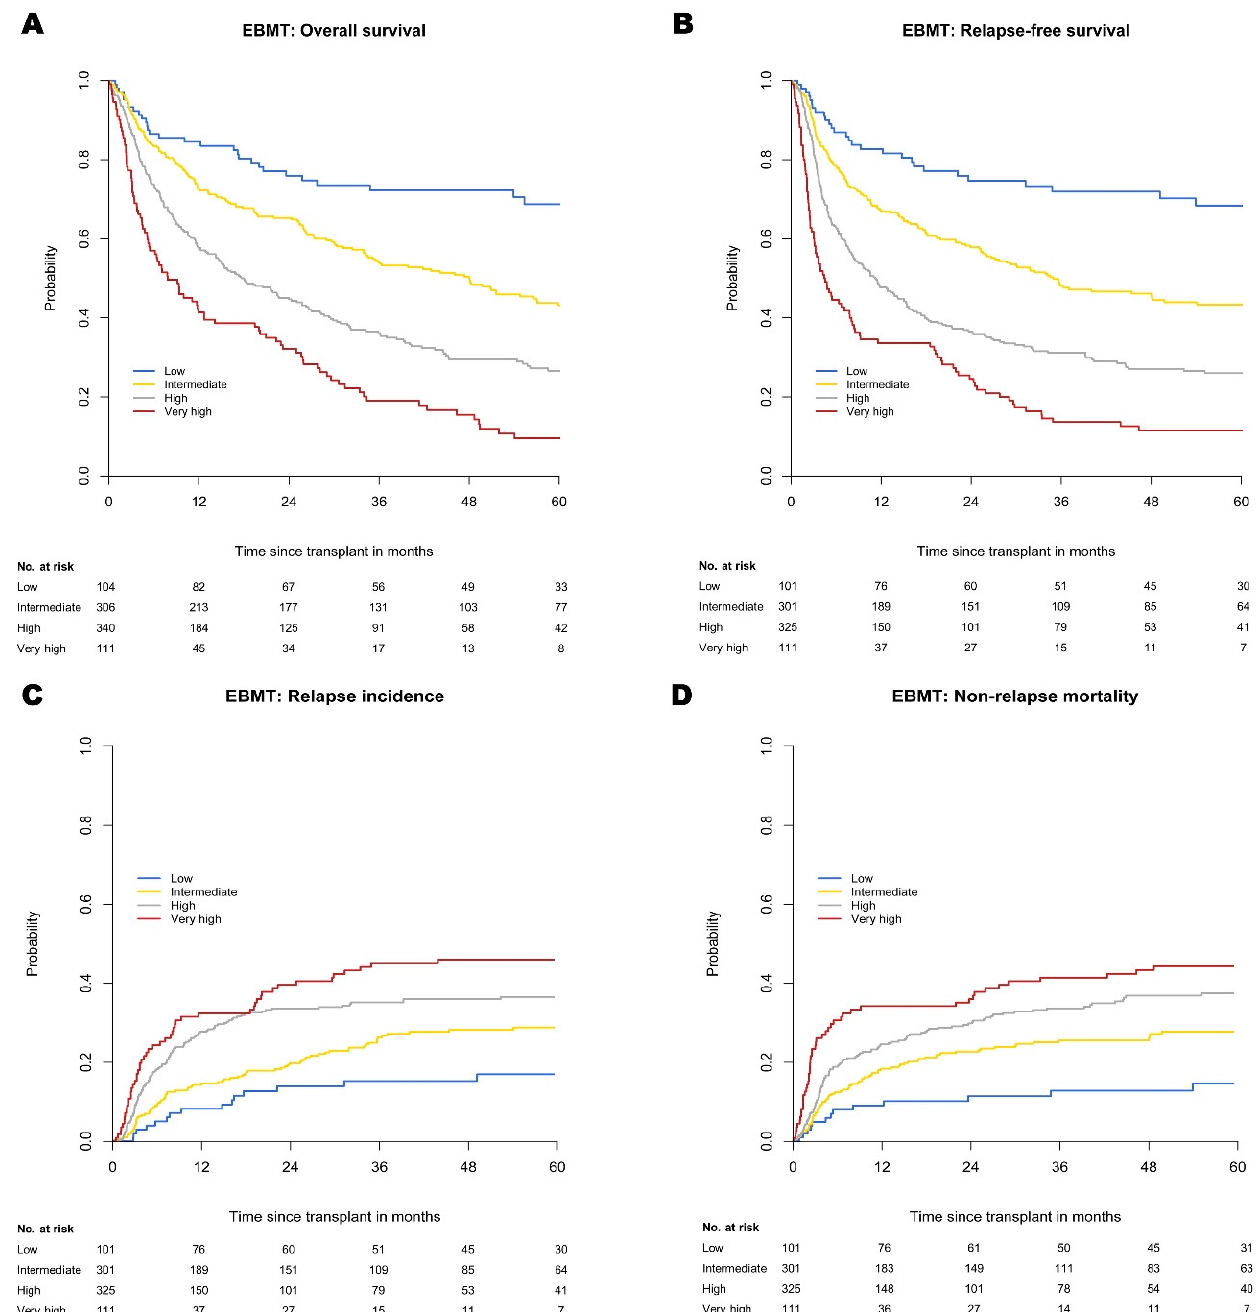
Figure 2. Outcome of MDS transplanted patients according to EBMT adapted score. This is a registry study from EBMT reporting a new score based on CMV serostatus recipient, Karnofsky score, and age for patient characteristics, cytogenetics, platelet count and blood blast count as disease risk, and donor type (Haematologica 2019, Gagelman [53]). The figure shows overall survival ( A ), relapse-free survival ( B ), relapse incidence ( C ), and non-relapse mortality ( D ) according to the EBMT adapted score.